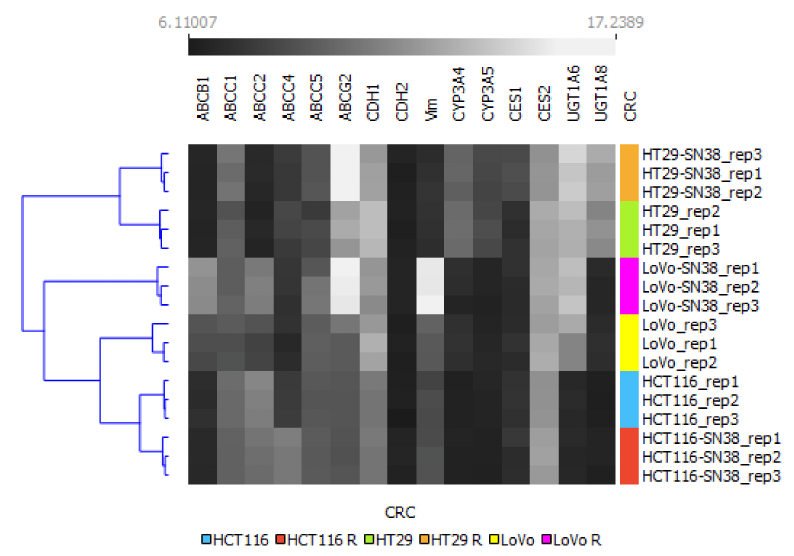
Figure 2. Hierarchical clustering analysis of CRC cell lines using mRNA expression profiles of irinotecan-resistance-related proteins. The expression values between SN-38-resistant variants and corresponding parental cell lines are grayscale; black represents low and white represents high expression values (6.1–17.23). A bidirectional hierarchical clustering heat map was visualized using the Orange data visualization